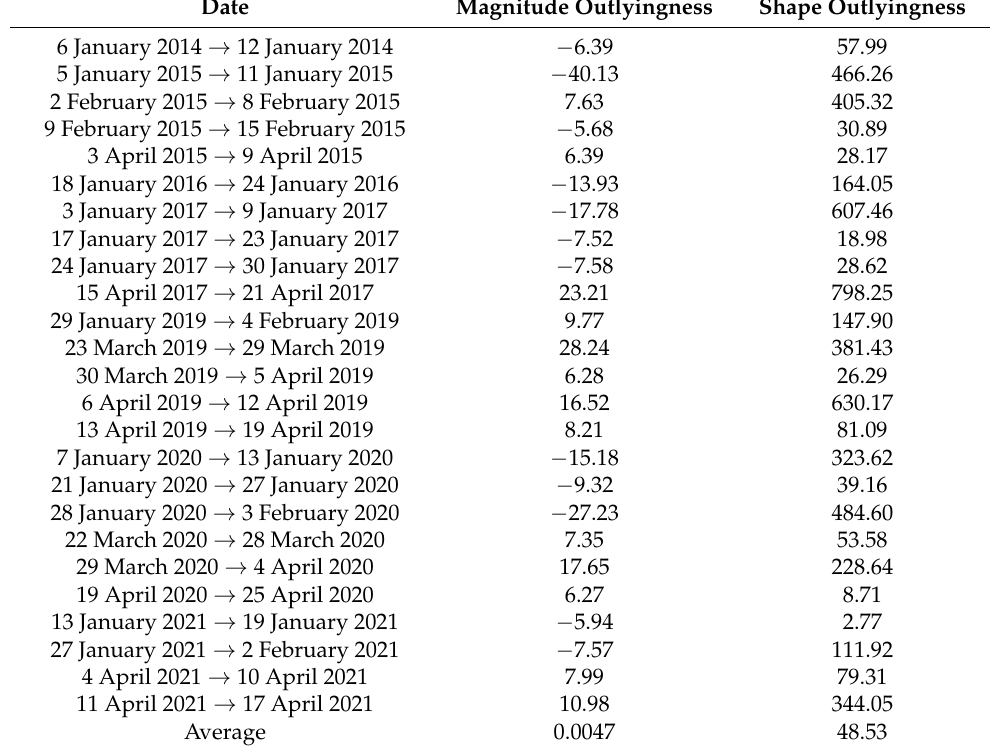
Table 4. Weekly O 3 outliers of the improved method with the modified band depth. The first column includes those outlying weeks of the first four months of every year, defined by their first and last day. The second column presents the magnitude outlyingness of those functions, which quantifies how much a function is shifted compared to the rest. The last column shows the shape outlyingness, a parameter that expresses to what degree a function has a different structure than the